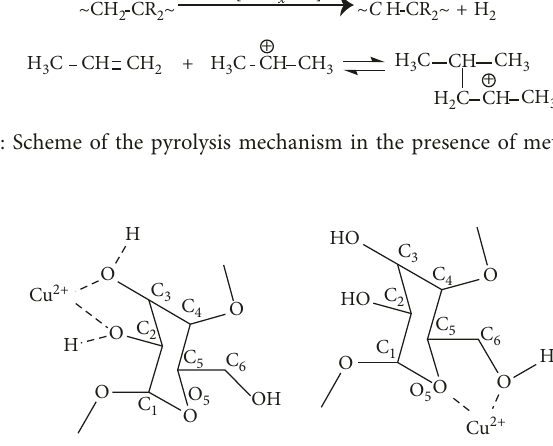
Figure 3: Scheme of the pyrolysis mechanism in the presence aprotonic acid centers.